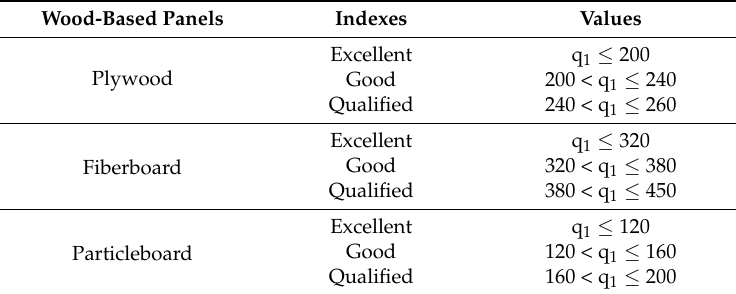
Table 2. Indexes of energy consumption for producing 1 m 3 of panels in the second stage (kgce/m 3 ). Wood-Based